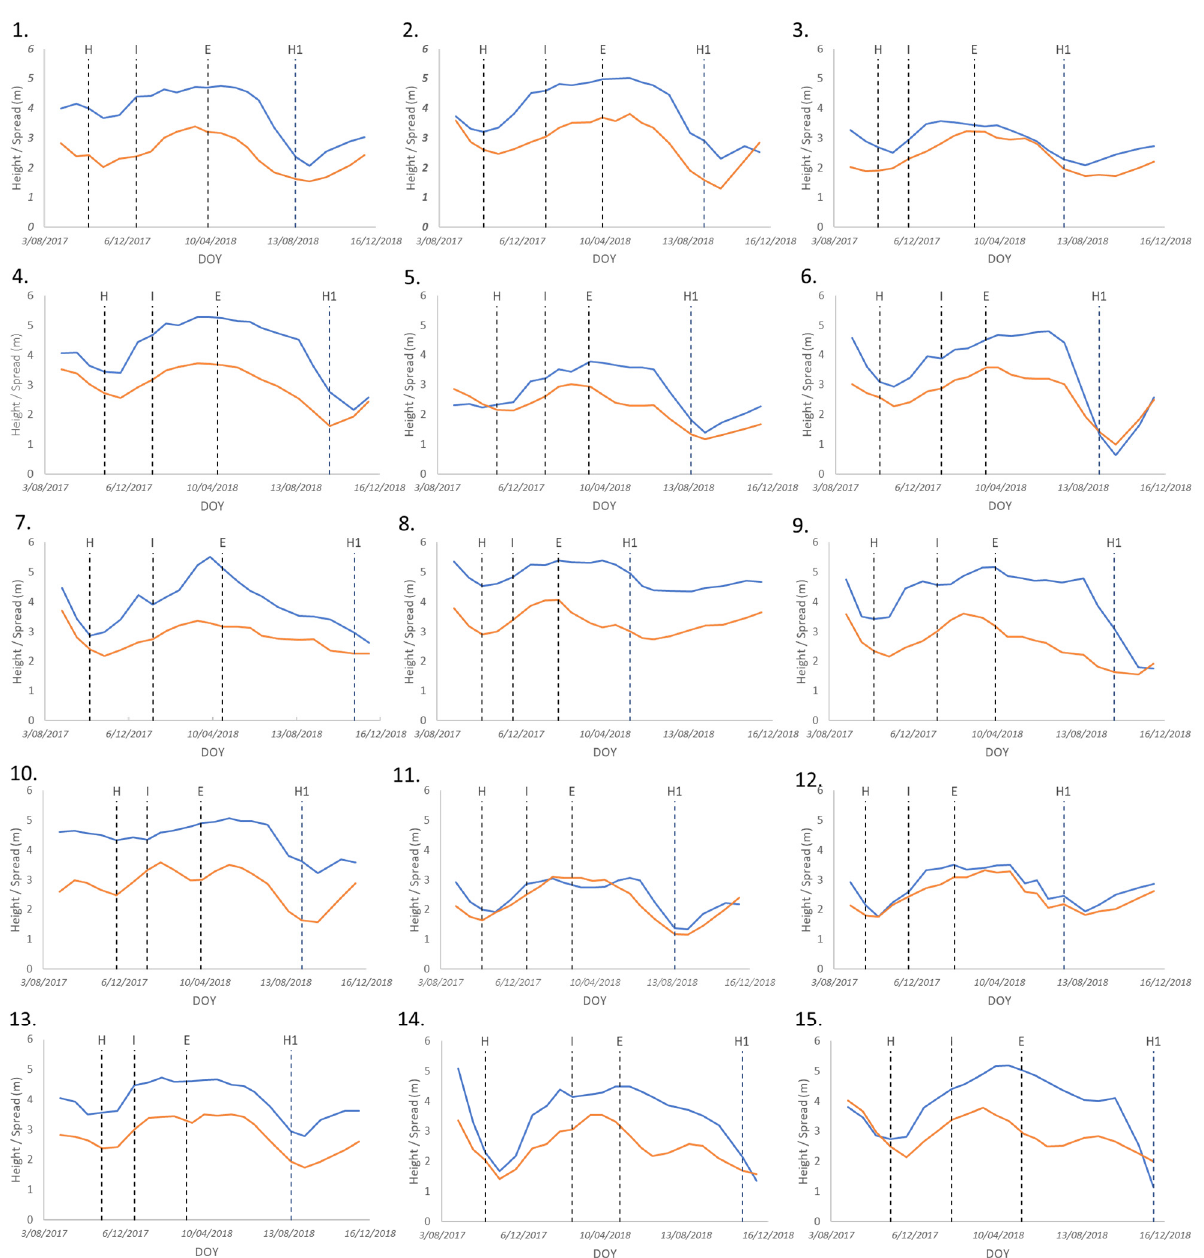
Figure 8. Time series of banana canopy height (blue) and canopy spread (orange) from 21 UAV data collections. Subfigure number indicates plant location (1–15). Vertical markers indicate the timing